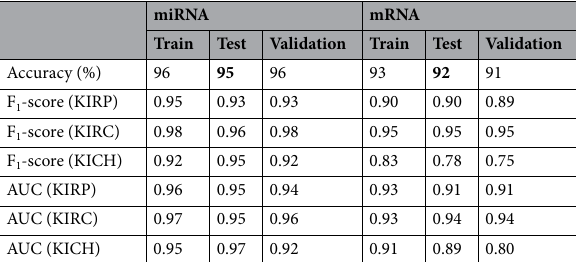
Table 2. The performance metrics for the classification step. Significant values are in bold. AUC Area under the Curve, KIRC kidney renal clear cell carcinoma, KIRP kidney renal papillary cell carcinoma, KICH kidney chromophobe carcinoma.